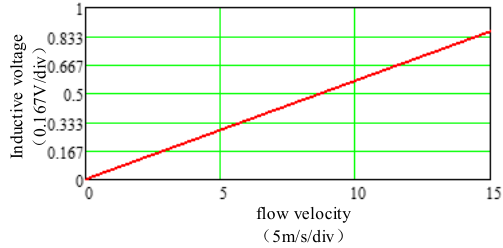
Figure 4. Induced voltage of the different size particles passing through the coils.